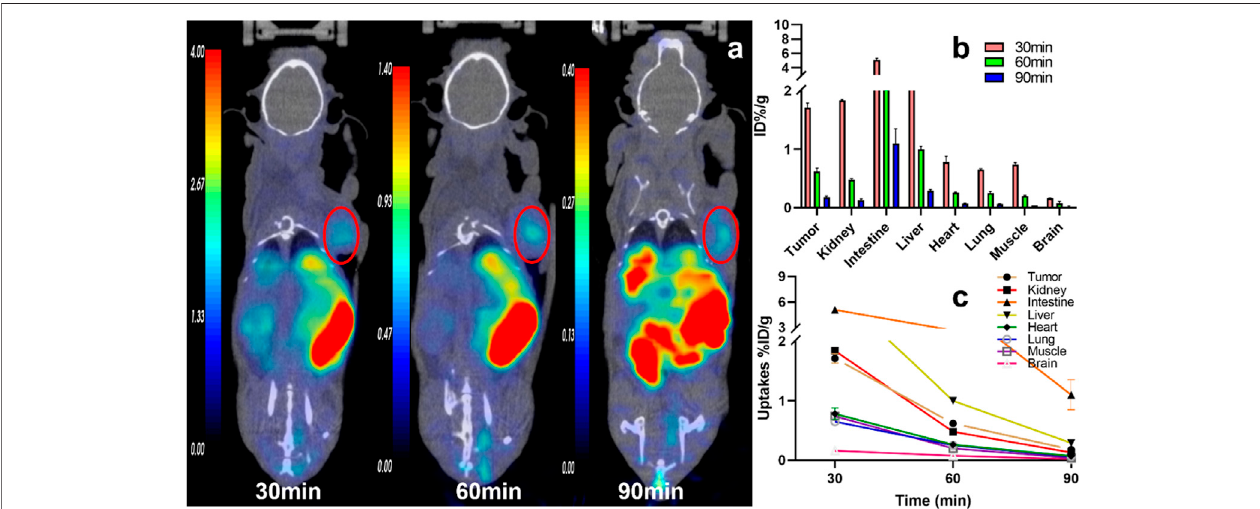
FIGURE 4 | The representative static PET imaging and distribution of 11 C-RJ1102, (A) the representative static PET imaging of 11 C-RJ1102 at 30, 60, 90 min in U87MG tumor-bearing nude mice.And the tumor wasindicatedby the red circle; (B) the organs or tissuesuptakesof 11 C-RJ1102in U87MG tumor-bearing nude mice at 30, 60, and 90 min; (C) the time – active curve (TAC) of 11 C-RJ1102 at 30, 60, 90 min.